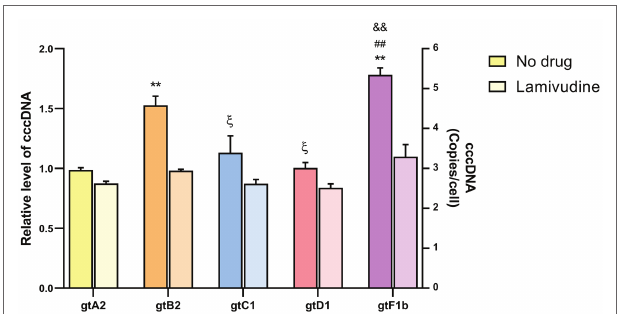
FIGURE 1 | Analysis of cccDNA levels among genotypes. HuH-7 cells were transfected with linear full-length HBV genomes of genotypes A2, B2, C1, D1, and F1b in the presence or in the absence of 100 μ m Lamivudine. 3 days post- transfection, cells were harvested, total DNA was extracted, and cccDNA levels were assessed by qPCR. Results were normalized to mitochondrial DNA. Shown values represent the mean ± standard deviation of three independent experiments. *: statistical difference in relation to gtA2, ξ : difference in relation to gtB2, #: difference in relation to gtC1 and &: difference in relation to gtD1. One symbol: p < 0.005 and two symbols: p <